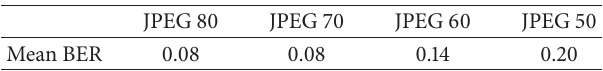
Table 1: Mean bit error rate of image dependent template under JPEG